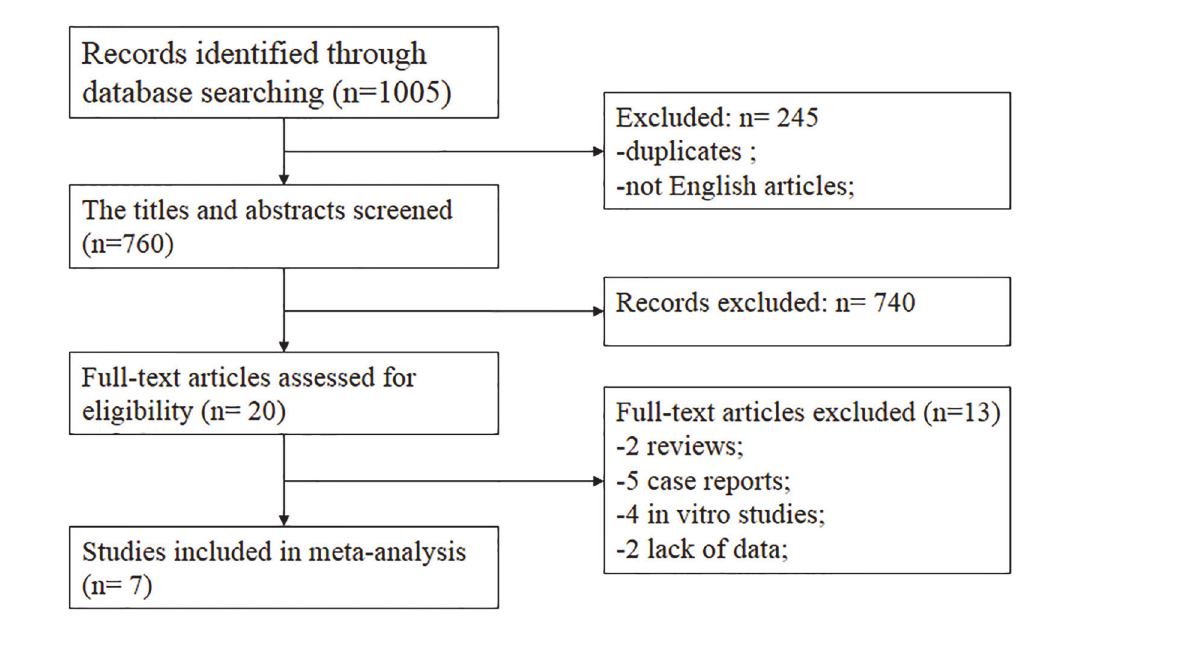
Fig 1. Flow diagram of study selection.